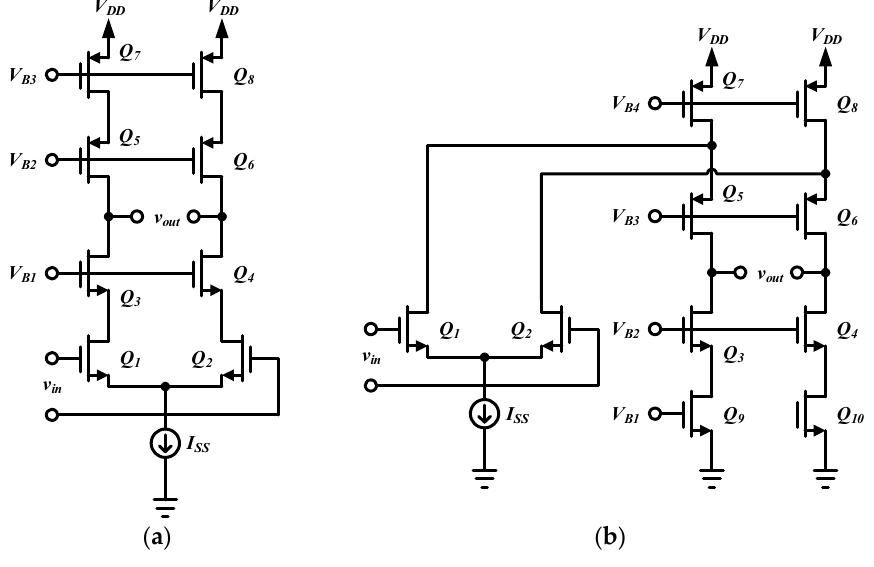
Figure 6. Schematic of telescopic amplifier.